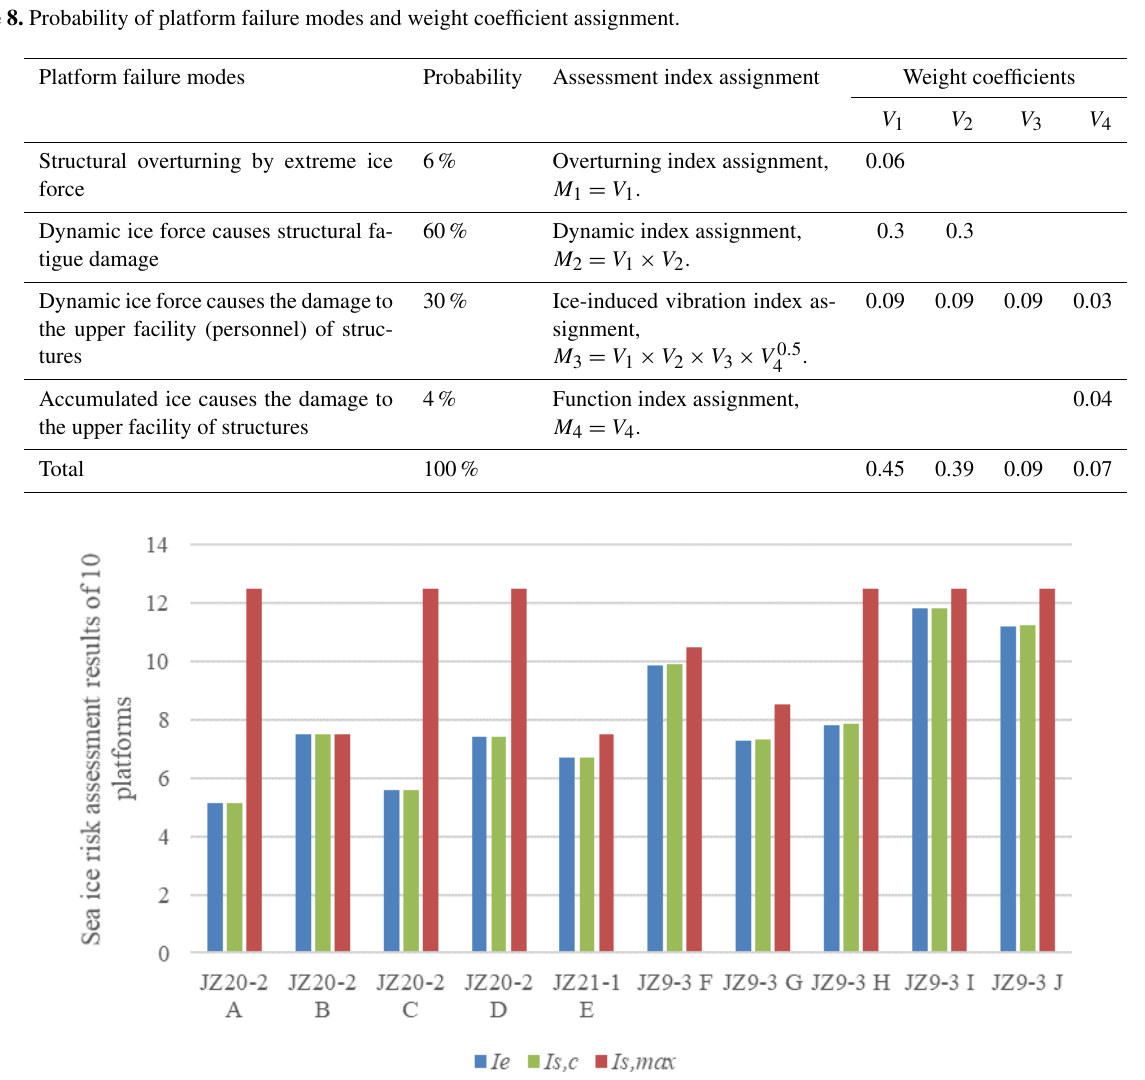
Table 8. Probability of platform failure modes and weight coefficient assignment.